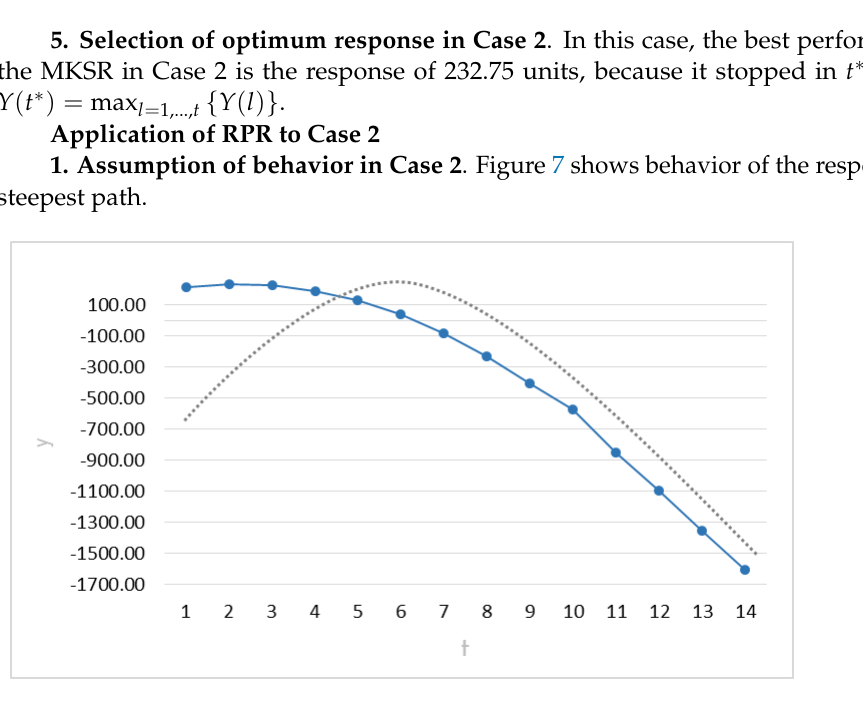
Figure 7. Graph with steepest descent path of y with a curved line, which assumes quadratic behavior in Case